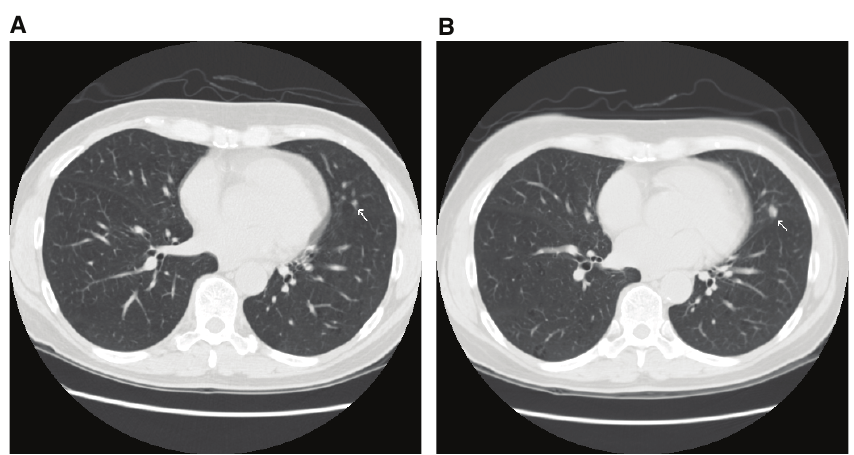
Figure 1. A 62-year-old woman, former smoker with a 40-pack year history, had a low-dose computed tomography (CT) screen showing a 3 mm nodule ( A ) in the left lung (lingula). At 1-year follow-up, the nodule had grown ( B ) and at surgical resection was a 6 mm adenocarcinoma. She remains without evidence of disease 9 years after